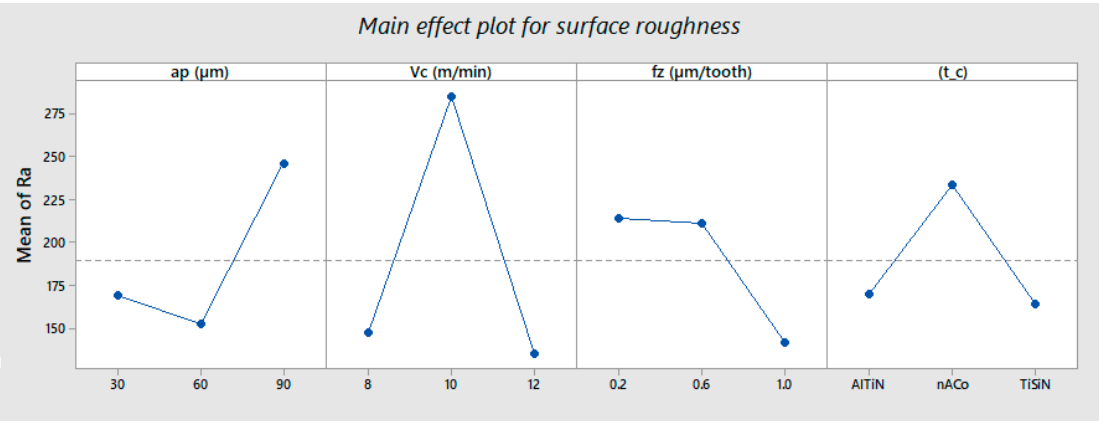
Figure 4. Main effect plot for surface roughness.